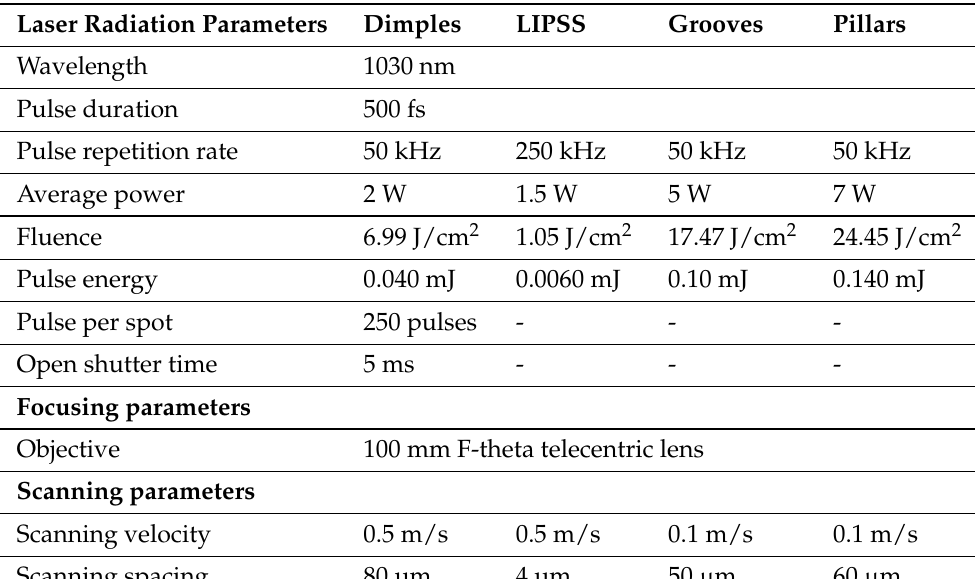
Table 1. Fabrication parameters of each